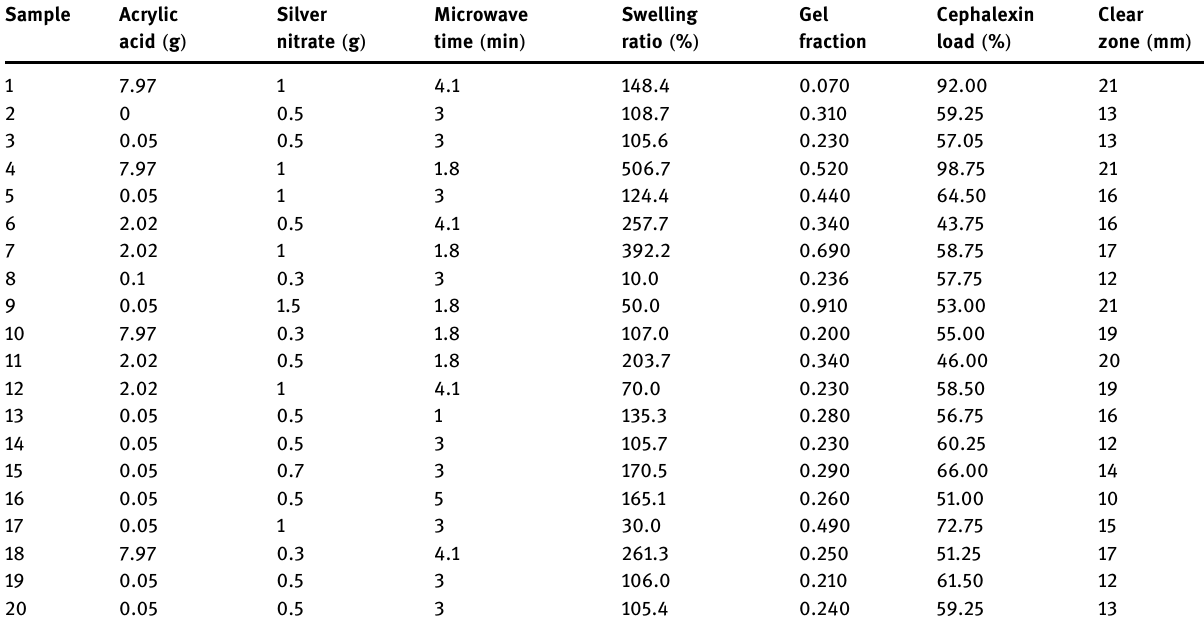
Table 1: Design of experiment and independent and response variables in the preparation of alginate/AAc composite hydrogels conjugated to silver nanoparticles